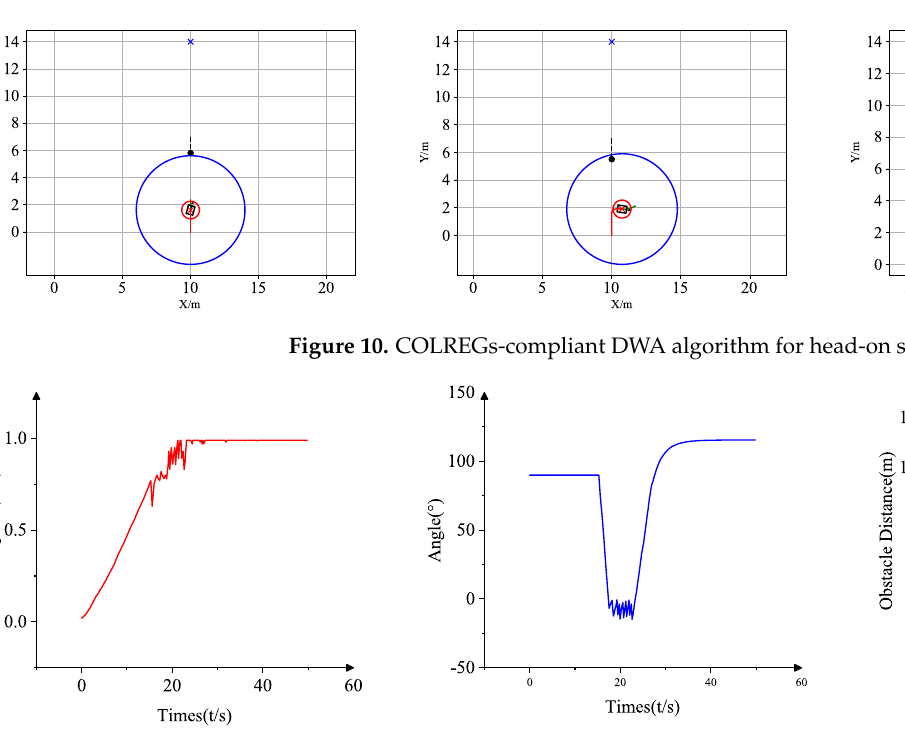
Figure 11. Parameters of the CCDWA algorithm for Head-on situation. (2) Overtaking situation